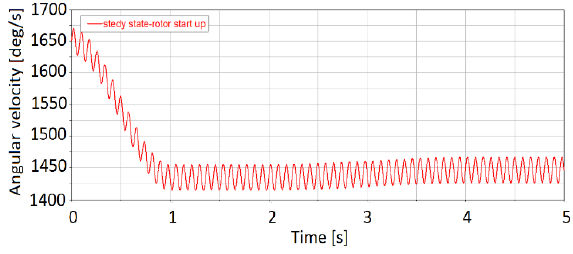
Fig. 14. Rotor lock and hover with SMA activation